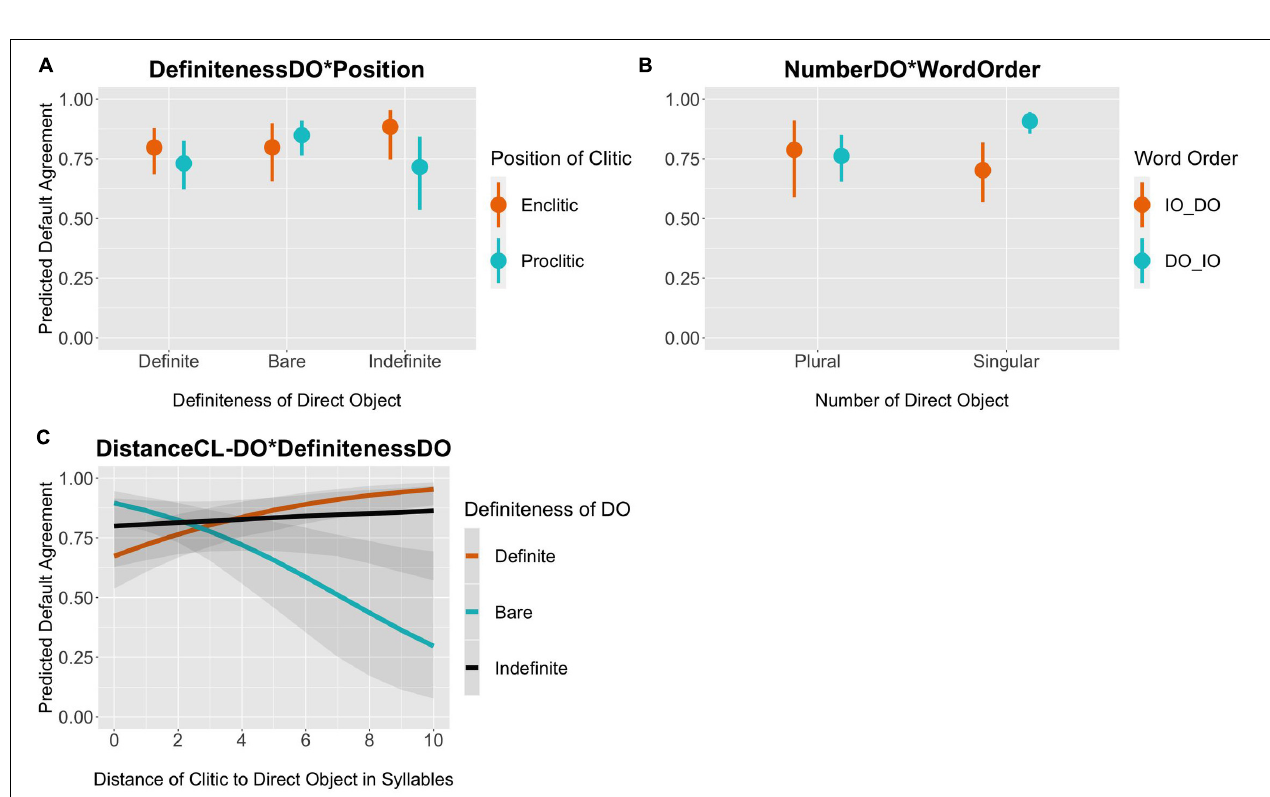
FIGURE 7 | Marginal effects of interaction terms on default agreement. The y-axis represents the posterior predicted probability of default agreement.